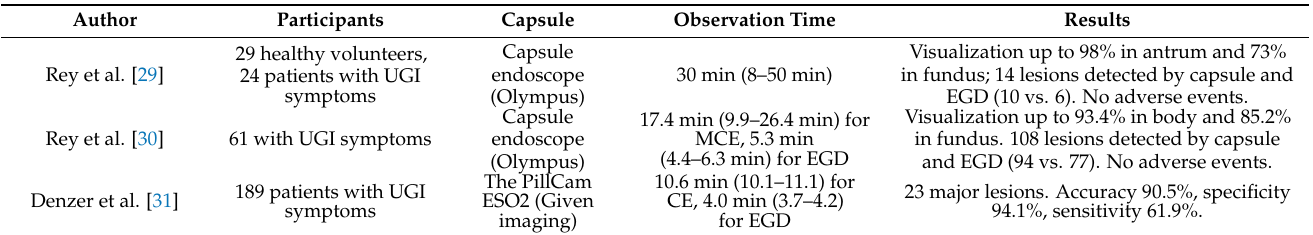
and EGD (94 vs. 77). No adverse